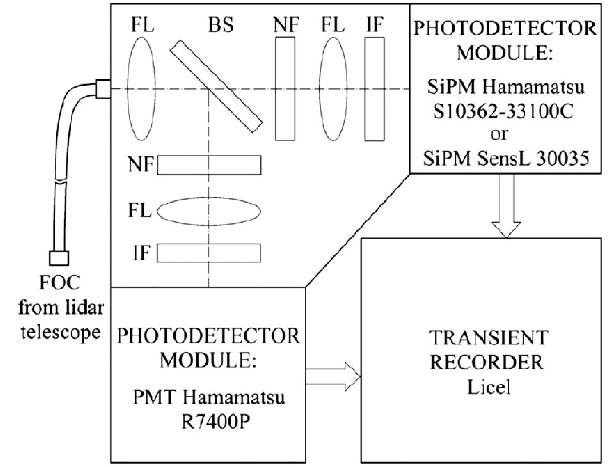
Fig. 4 Flow chart of the optical operating system.